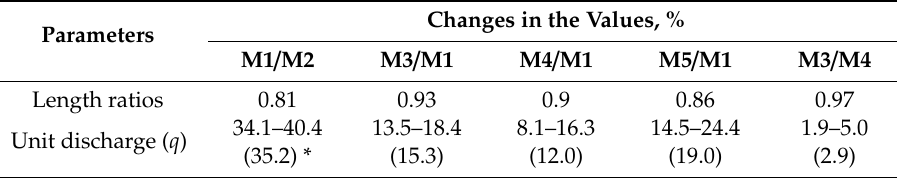
* Average values. Table 4. Percentage changes in the discharge coe ffi cients due to the corner shapes. Table 4. Percentage changes in the discharge coefficients due to the corner shapes.